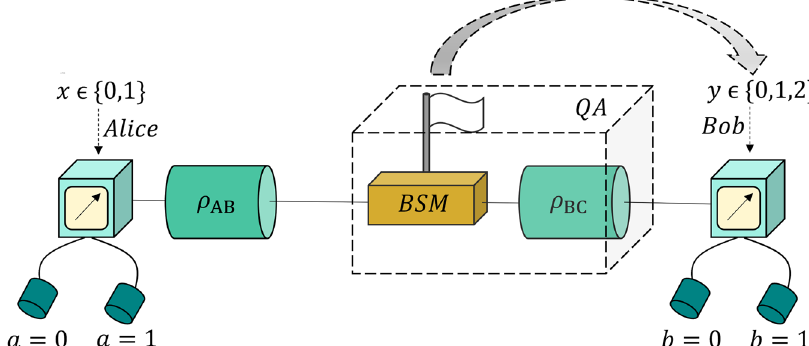
Fig. 2 QA-assisted DI-QKD. One possibility consists of locating the entanglement source ρ AB at Alice ’ s site, such that only Bob experiences channel loss, and thus he is the one equipped with a QA. Alternatively, one can place ρ AB in the channel and equip both Alice and Bob with QAs. For instance, the QA may be constructed with an auxiliary entanglement source ρ BC and a Bell state measurement (BSM). In the BSM, a traveling photon from ρ AB interferes with a photon from ρ BC . Upon success of the BSM, Bob is warned of the arrival of a photon — which is symbolized by a fl ag within the QA — and the entanglement is swapped to the extreme photons entering Alice ’ s and Bob ’ s measurement devices. Only in this successful event, Bob selects his measurement setting. In this way, unheralded signals can be withdrawn without opening the detection loophole. For the purpose of key generation, Bob ’ s device admits a third input setting ( y = 2) matching one of Alice ’ s test